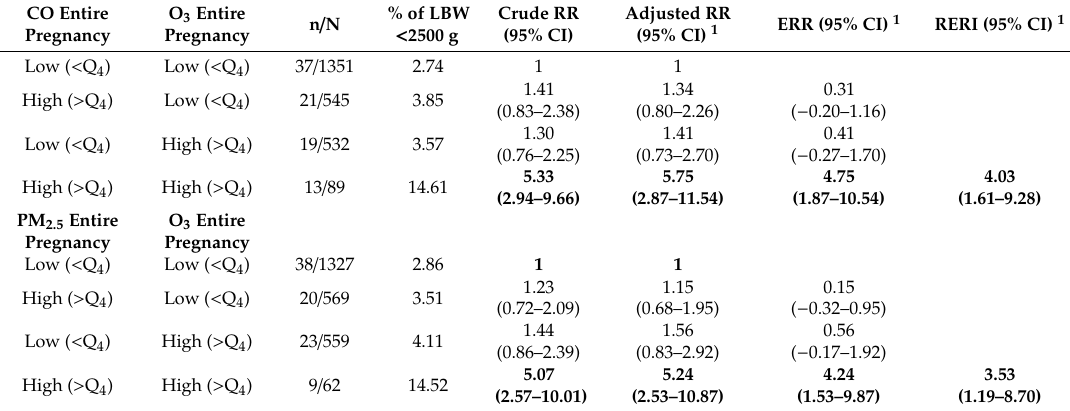
Table A4. Joint e ff ect of CO and O 3 and of PM 2.5 and O 3 during entire pregnancy on low birth weight less than 2500 g, The Espoo Cohort Study,